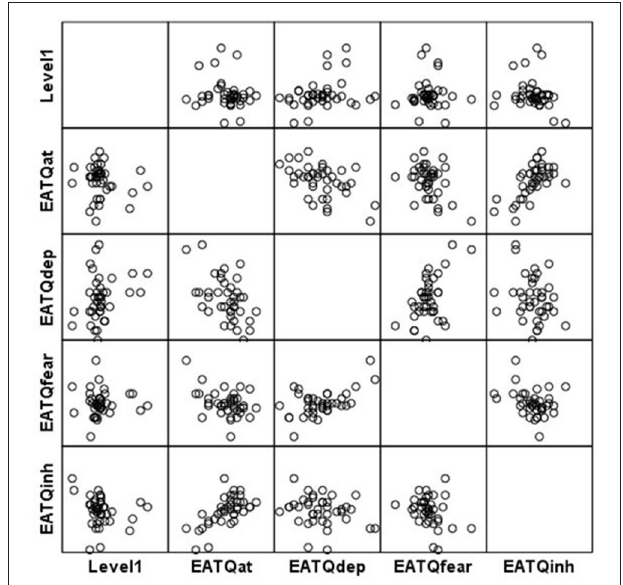
FIGURE 2 | Scatterplot matrix for Level 1